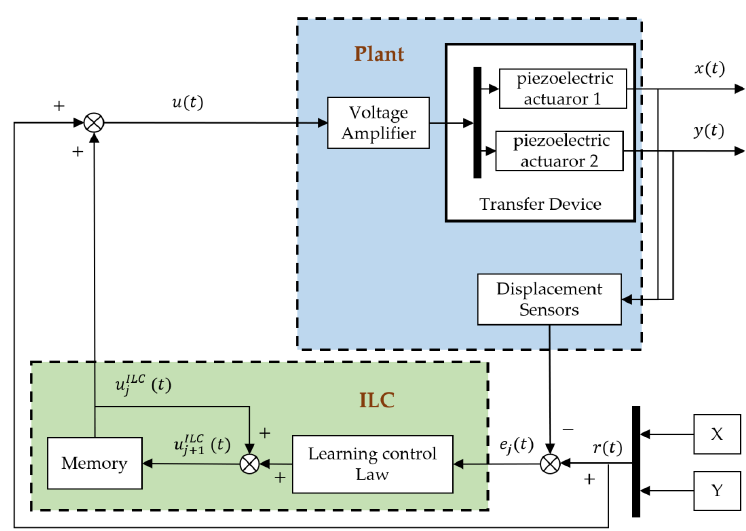
Figure 8. The diagram of the control scheme in this